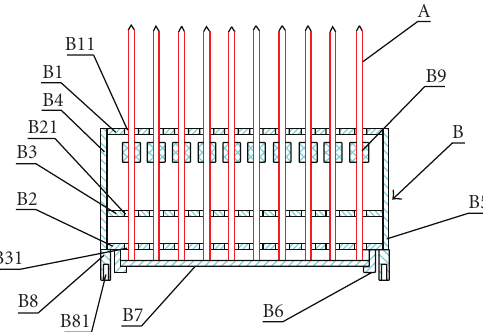
Figure 2: Schematic of the instrument Section 1.